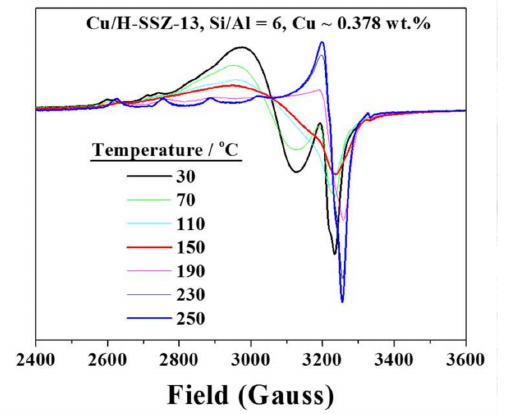
Figure 3. Electron Paramagnetic Resonance (EPR) spectra of a Cu/SSZ-13 sample (Si/Al = 6, Cu/Al = 0.032) during dehydration. Reprinted from J. Catal. , 2014 , 319 , 1–14. Copyright 2014, with permission from